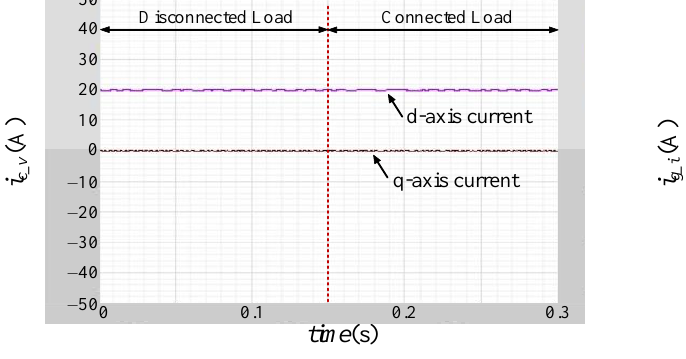
Figure 11. The frequency and amplitude of output voltage under droop control ( f 0 = 50 Hz, V 0 = 300 V). ( a ) Voltage frequency ( i dref = 20 A); ( b ) Voltage amplitude ( i qref = 20 A). Second, the secondary control is implemented in the voltage-controlled converter to eliminate the error of frequency and amplitude of voltage caused by the droop control. The frequency of voltage under the secondary control is shown in Figure 12a and is equal to the given frequency due to the compensation generated by the secondary control. The amplitude of voltage under the secondary control is shown in Figure 12b and is equal to the given amplitude due to the compensation generated by the secondary control.